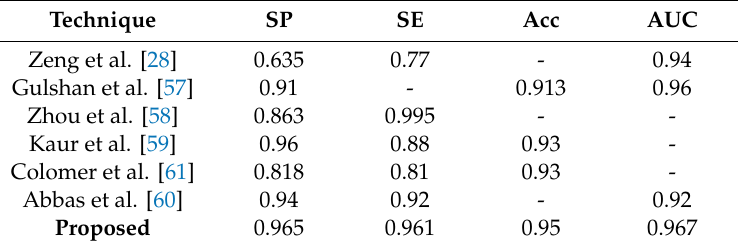
Table 7. Performance comparison against DR detection methods.